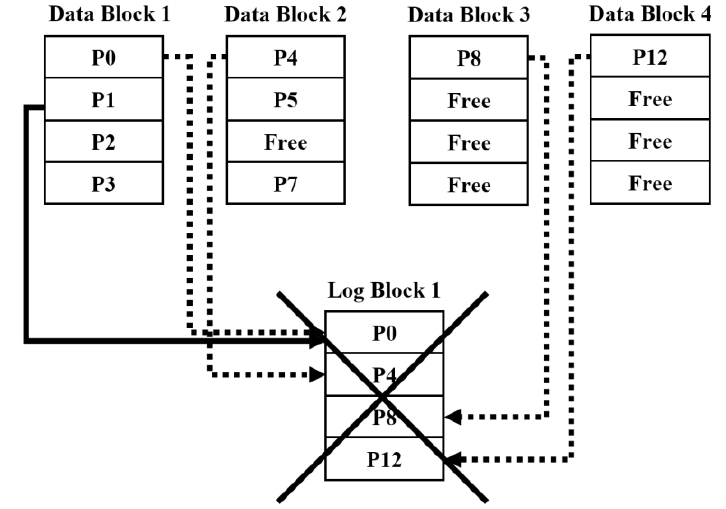
Figure 4. Low space availability of a data block.